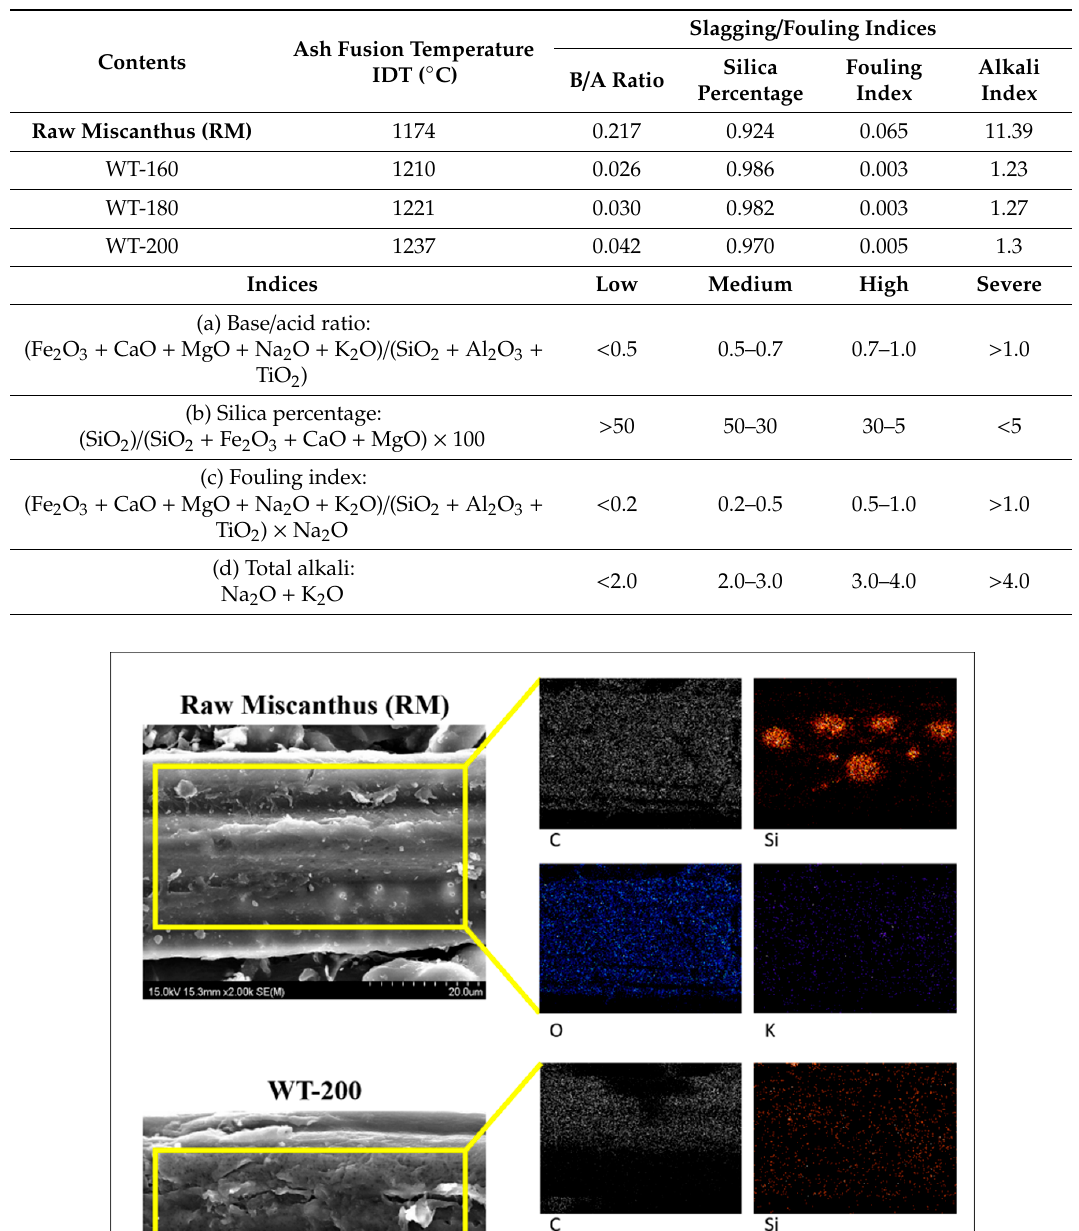
Table 5. IDT, Slagging and Fouling indices of raw miscanthus (RM) and wet torrefaction (WT) samples.